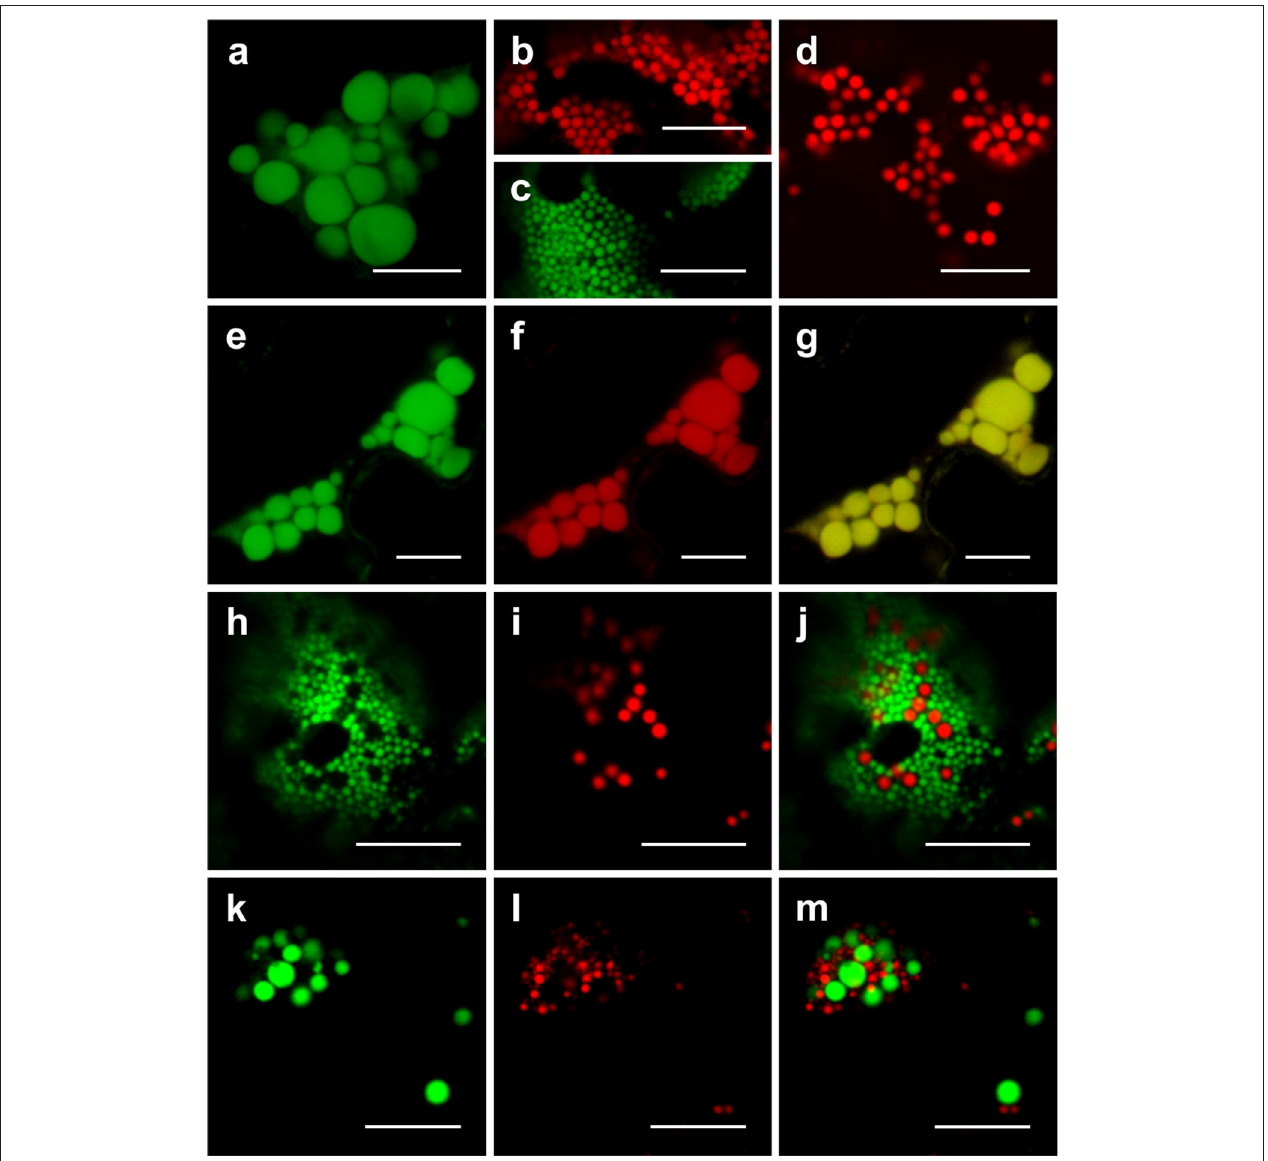
FIGURE 3 | Co-expression of ELP-, HFBI-, and Zera-fused fluorescent proteins. When expressed alone, GFP-ELP (A) promotes the formation of clusters of large PBs, RFP-HFBI (B) , and GFP-HFBI (C) form clusters of small PBs, and Zera-DsRed (D) induces the formation of small PBs. (E–G) Co-expression of GFP-ELP and RFP-HFBI results in co-localization of the recombinant proteins into the same large PBs. (H–J) Co-expression of GFP-HFBI and Zera-DsRed results in distinct PBs. ( K–M) Co-expression of GFP-ELP and Zera-DsRed results in distinct PBs. All images were acquired at 4-dpi in sequential mode. Bar, 10 µ m.